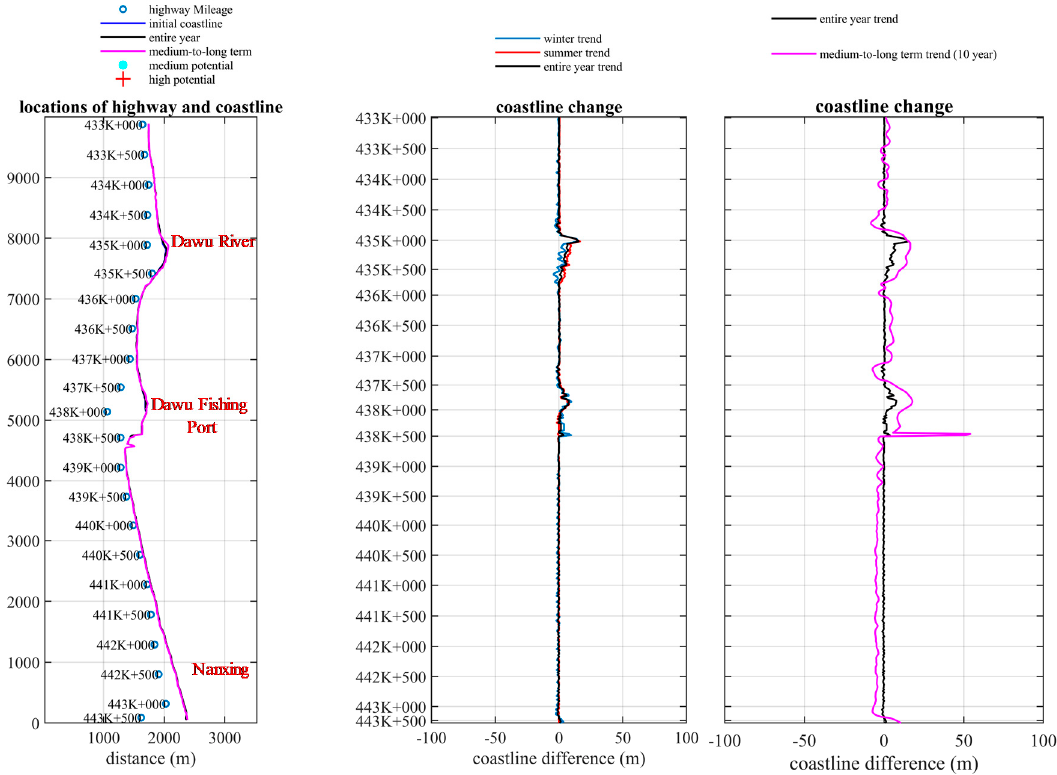
Figure 28. Map of the potential for erosion in Region A.